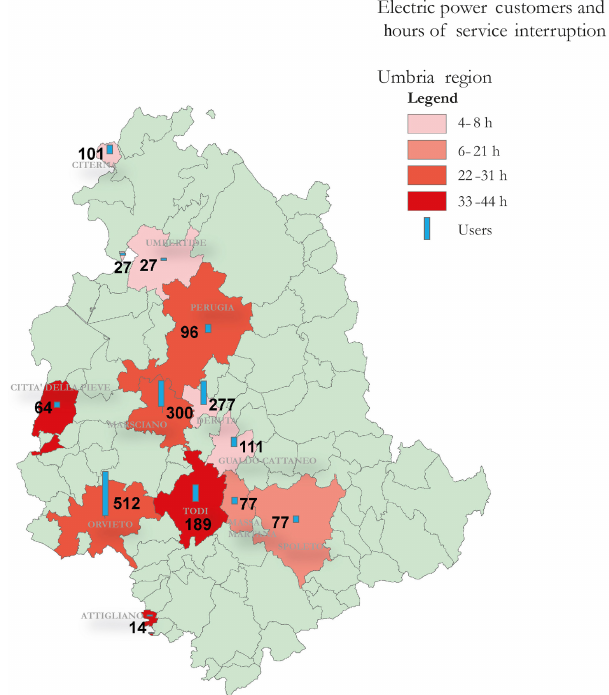
Figure 5. Overview of electricity disruption at regional level: af- fected users and duration of the disruption per